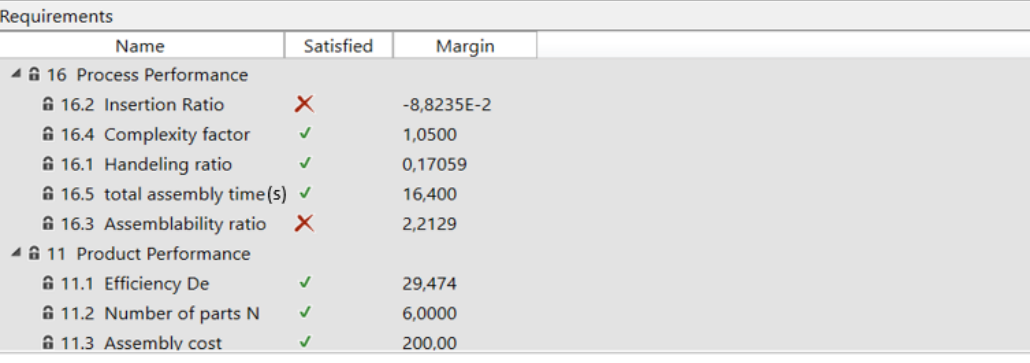
Figure 10. ASP2 response to system specifications.